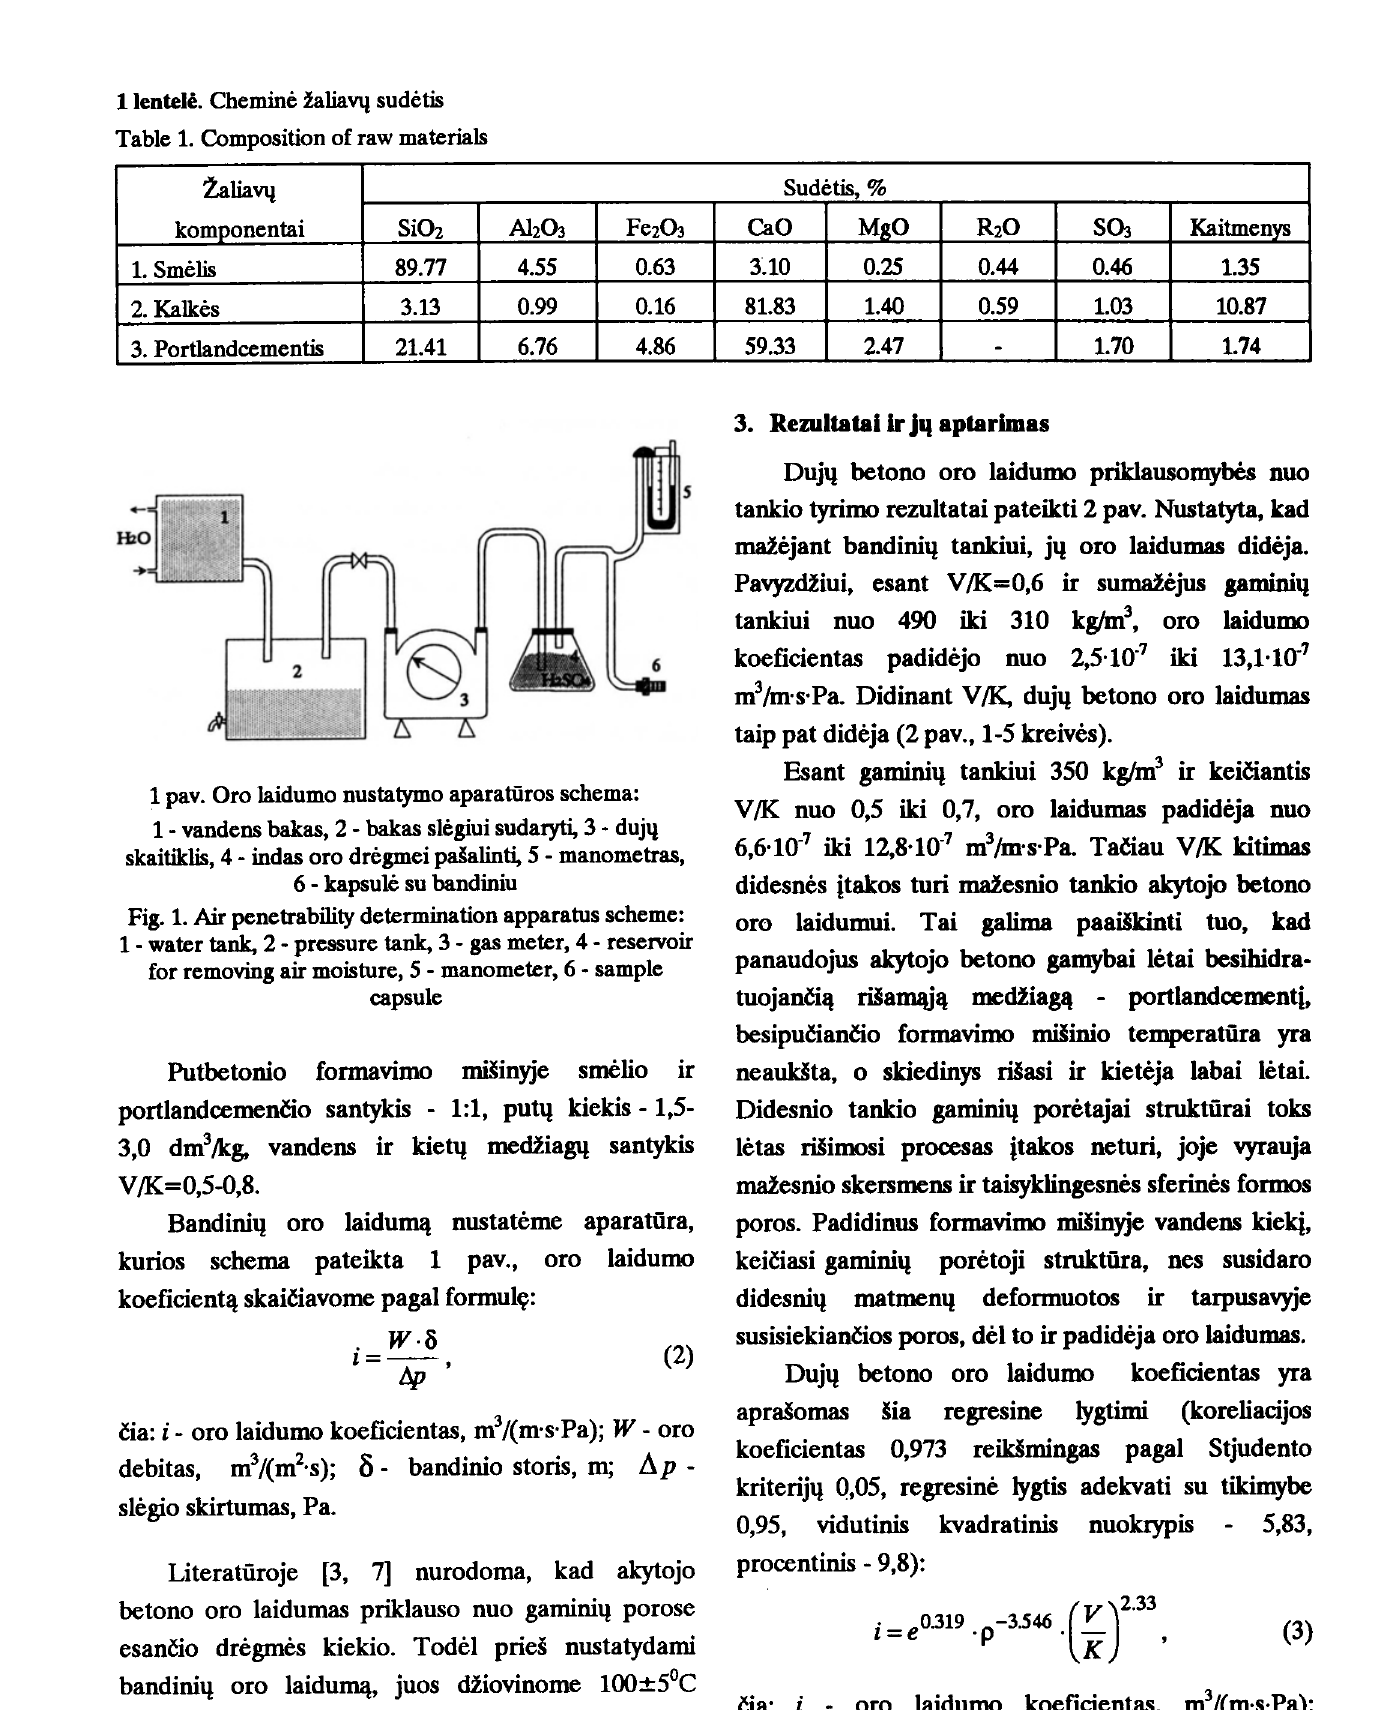
Fig. 1. Air penetrability determination apparatus scheme: 1 - water tank, 2 - pressure tank, 3 - gas meter, 4 - reservoir for removing air moisture, 5 - manometer, 6 - sample